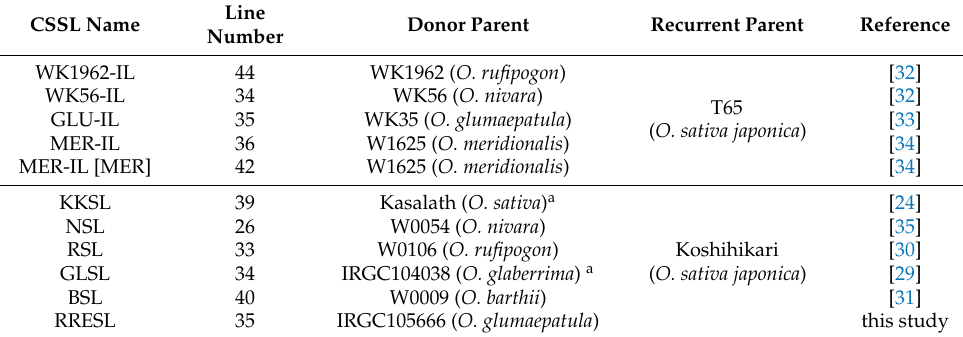
Table 1. The list of CSSLs used in this